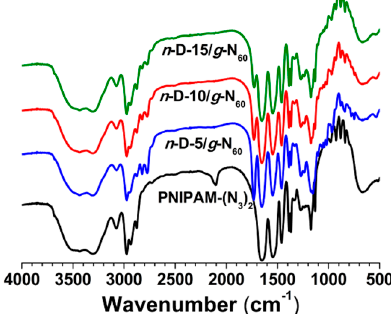
Figure 4. FT-IR spectra of network-graft hydrogels from P(DMAEMA- co -ProA) and PNIPAM 60 –(N 3 ) 2 .